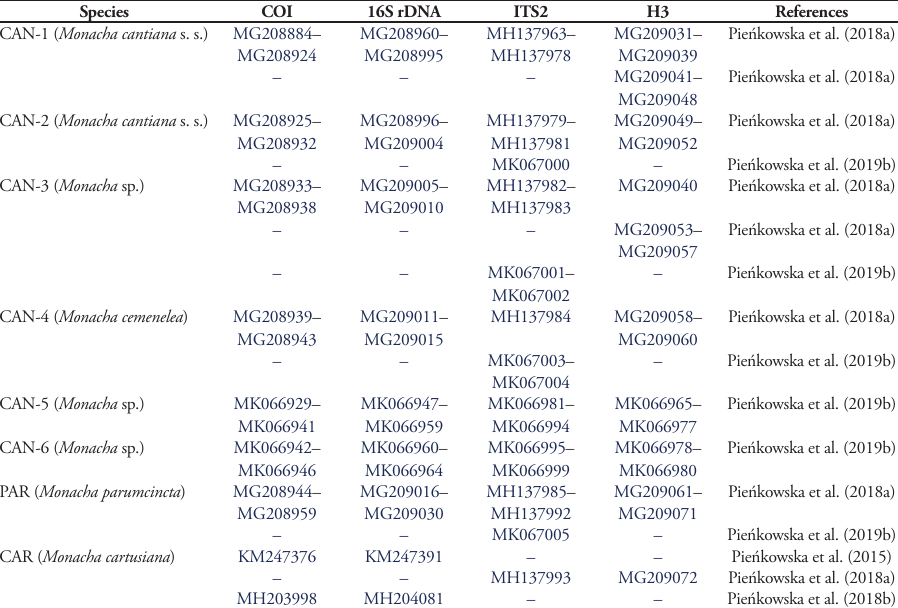
Table 2. GenBank sequences used for molecular analysis